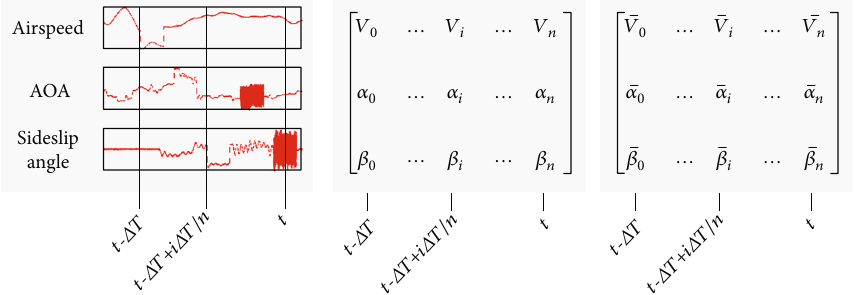
Figure 4: Data preprocessing for ADS. (a) ADS records are retrieved from real fl ight/simulation, faults are injected into the records; a time window ( Δ T ) is implemented to clip the data, which is further down-sampled to 1 Hz. (b) the clipped and downsampled data are stacked as the matrix. (c) along each row, the states are normalized linearly within the range of [0, 1], which eventually yields a 3 × 31 state image for the ADS data. Same approaches are also used for accelerations, rotational speeds, etc.